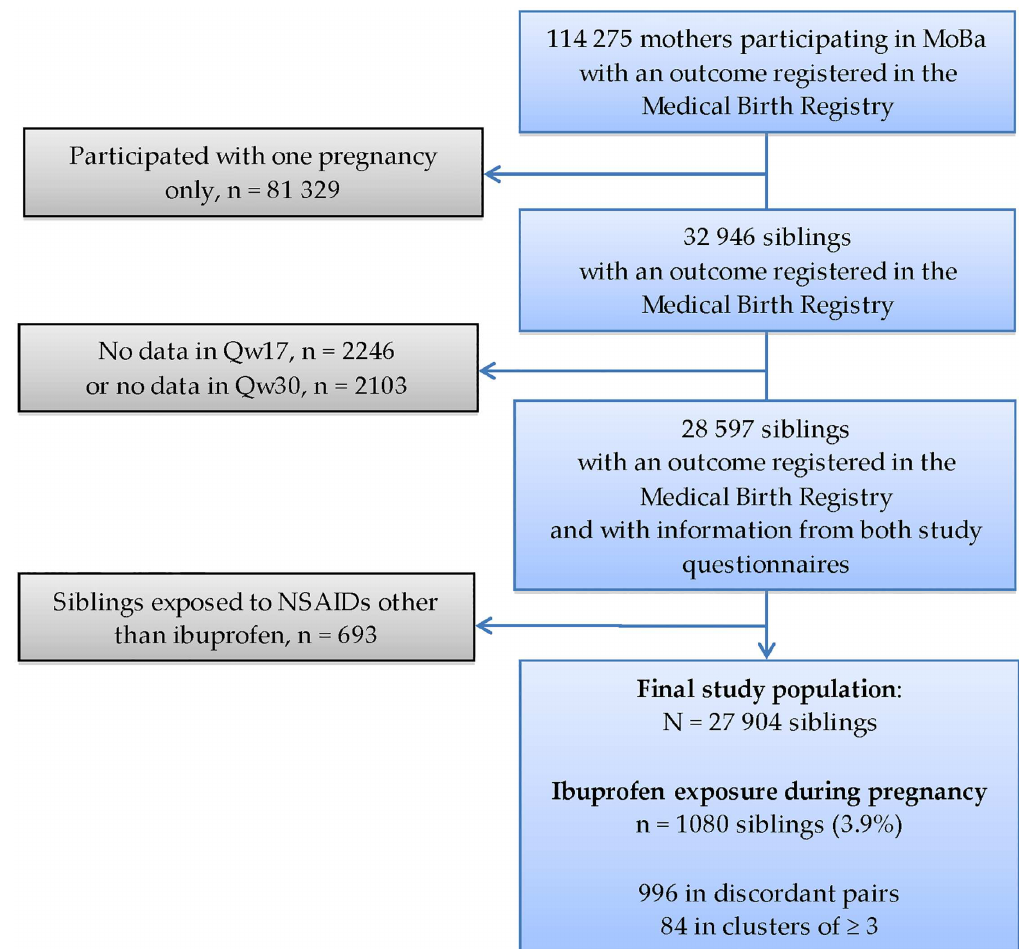
Fig 1. Population flow diagram. MoBa: Norwegian Mother and ChildCohort Study. NSAIDs: Nonsteroidal antiinflammatory